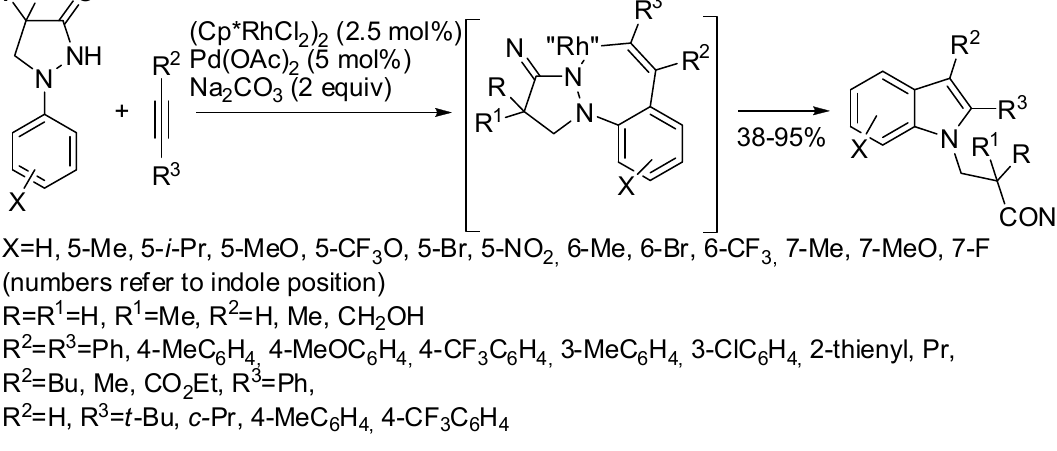
Scheme 51. Synthesis of N -substituted indole derivatives from phenidones.